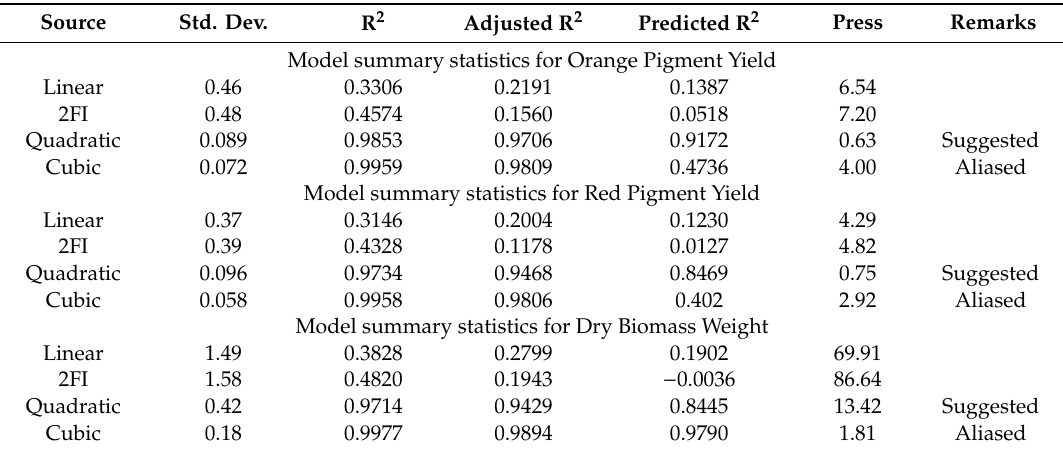
Table 3. Model summary statistics for